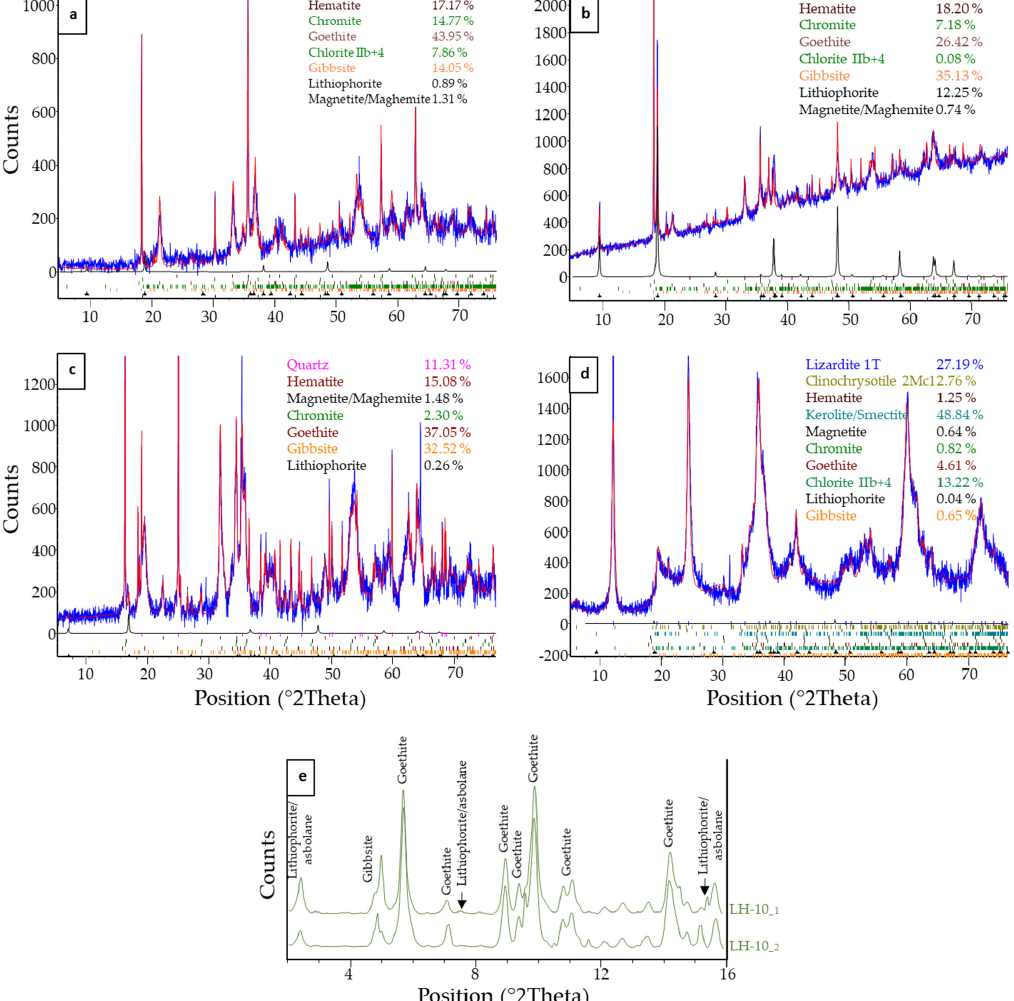
Figure 4. ( a – d ) X-ray diffraction patterns obtained for samples LC-6 ( a ), LC-7-black ( b ), LH-11 ( c ), and LH-10 ( d ). In blue, experimental data; in red, Rietveld fit, and in black, lithiophorite spectra. Mineral percentages obtained after Rietveld interpretation ( λ = 1.5406 Å). ( e ) Two micro-XRD measurements of sample LH-10 obtained at ALBA synchrotron ( λ = 0.4246 Å). Thermogravimetry showed that samples from Loma Caribe experience a mass loss of about 4% before 260–280 °C, probably due to the loss of adsorbed water for tempera- tures below 110–160 °C [33,34] and to the transformation of gibbsite to boehmite, which is reported to occur at temperatures between 150 and 260 °C [34] (Figure 5a). Between 260 and 320 °C, the mass loss is between 5 and 8%. The latter process can be ascribed to the loss of the OH − groups in the reaction from goethite to hematite (Figure 5a). This reaction (i.e., 2FeOOH Fe 2 O 3 + H 2 O) occurs at temperatures between 300 and 344 °C [35] or 270 and 330 °C [36], and it is commonly associated with a mass loss of 10% or less if there are secondary phases. This mass loss coincides with an endothermic peak around 325 °C in the DTA curve (Figure 5b) that is considered as the result of the breakdown of goethite [34–36].